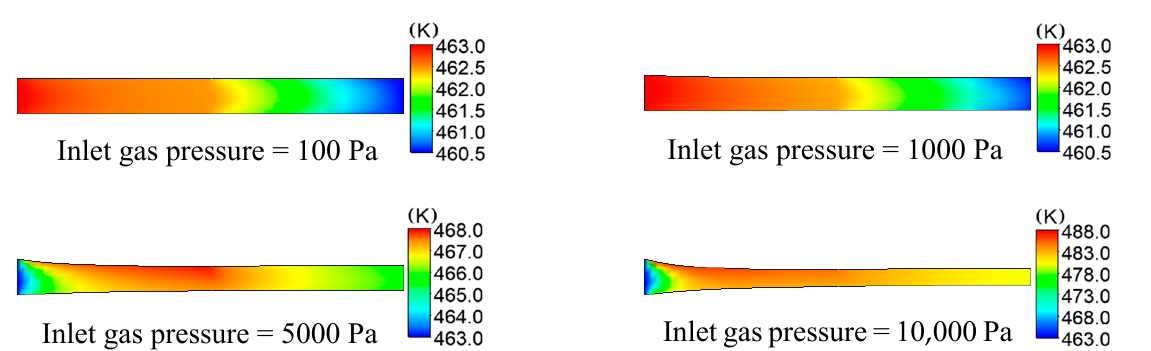
Figure 6. Distributions of temperature under different inlet gas pressures.